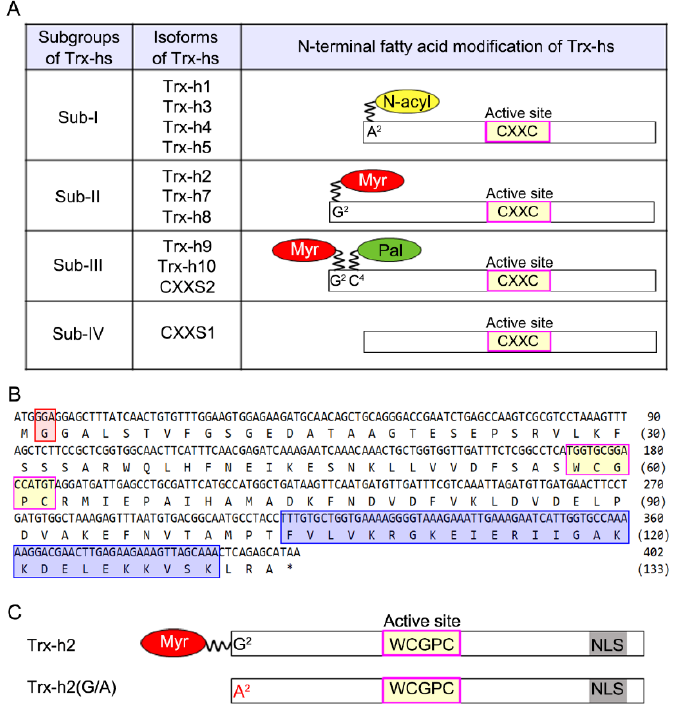
Figure 1. Schematic representation of the four Arabidopsis Trx-h subgroups, Trx-h2 amino acid sequence, and Trx-h2 and Trx-h2(G/A) DNA constructs. ( A ) Classification of Trx-h subgroups in Arabidopsis. The Trx-h isoforms are categorized into four subgroups, depending on the fatty acid modification of N-terminal amino acids. Critical amino acids for fatty acid modifications include Ala 2 (A 2 ), GLy 2 (G 2 ), and Cys 4 (C 4 ). N- α -acetylation, myristoylation, and palmitoylation are indicated by yellow, red, and green circles, respectively. The active site of Trx-hs containing the CXXC motif is indicated by the magenta box. ( B ) Amino acid sequence of Trx-h2. The second Gly (Gly 2 ) residue of Trx-h2, involved in myristoylation, is indicated by a red box, and the WCGPC motif and bipartite NLS are indicted by yellow and blue boxes, respectively. ( C ) Schematic of the protein constructs of Trx-h2 and Trx-h2(G/A). Gly 2 residue in Trx-h2 is indicated in black font, while its substitution, Ala 2 , in Trx-h2(G/A), is indicated in red font. The NLS is represented by a gray